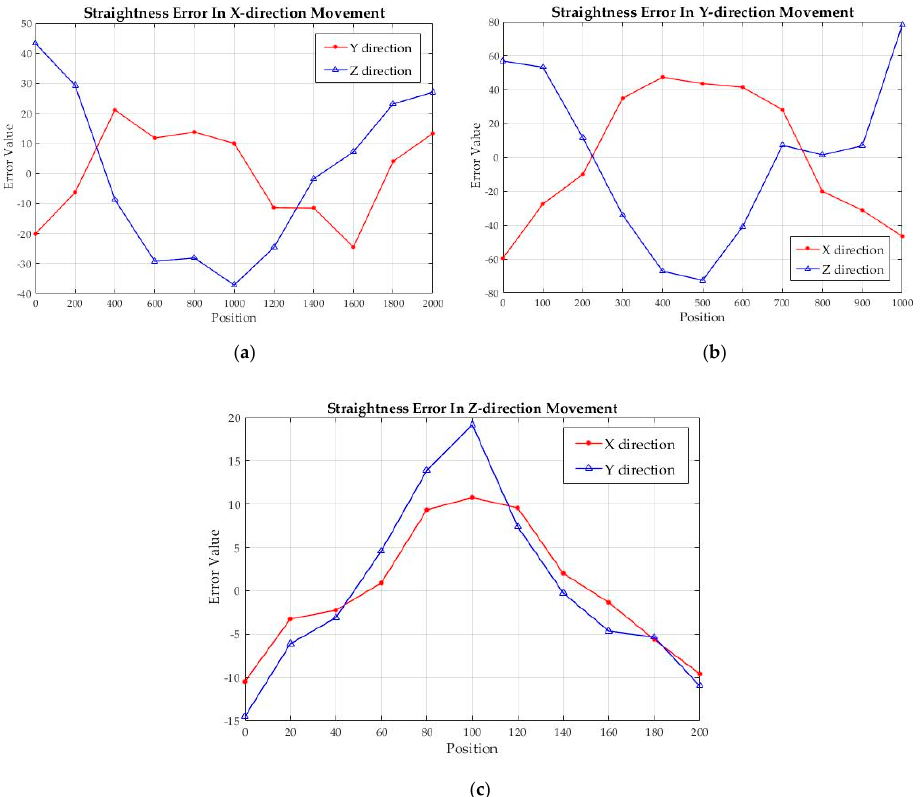
Figure 6. Image of straightness error. ( a ) Straightness error in the X-direction movement; ( b ) Straightness error in the Y-direction movement; ( c ) Straightness error in the Z-direction movement. According to Figure 6, the max value of the straightness errors is lower than the position errors.